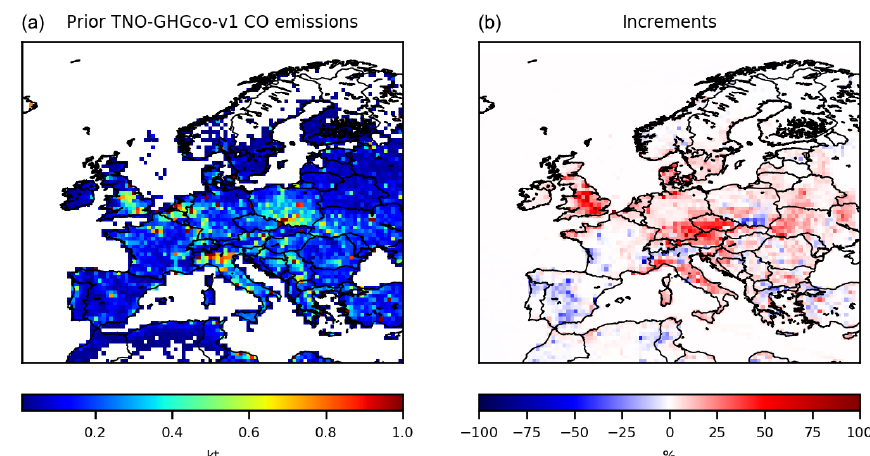
Figure 7. (a) TNO-GHGco-v1 CO anthropogenic prior emissions, in ktCO per grid cell, and (b) increments provided by the inversion with constraints from MOPITTv8-NIR-TIR from 1 to 7 March 2015, in %. Table 4. Statistics for the comparison between simulated and observed CO surface concentrations over central and eastern Europe (see the area in purple in Fig. 5). MB = mean bias, RMSE = root mean square error, SD = standard deviation are in ppbv. The spatial correlations r are presented with their p value. Prior Posterior